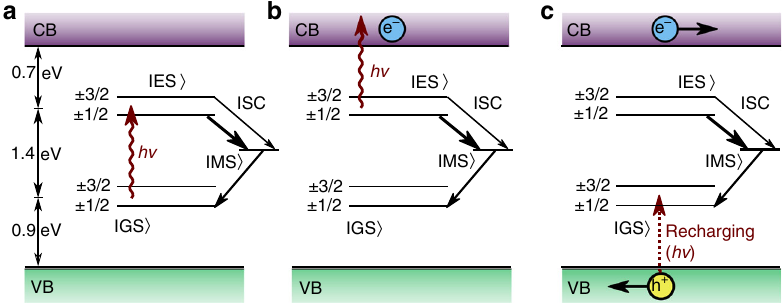
Fig. 1 Photocurrent detected magnetic resonance (PDMR) mechanism and readout. a Single photon excitation. Excited state (ES) can relax to either ground state (GS) or metastable state (MS). Intersystem crossing (ISC) to MS is dependent on the spin state in ES, thus GS is polarized. b Second photon ionizes the defect and introduces a free electron in the conduction band (CB). c Recharging of the defect from valence band (VB) and separation of charges lead to a